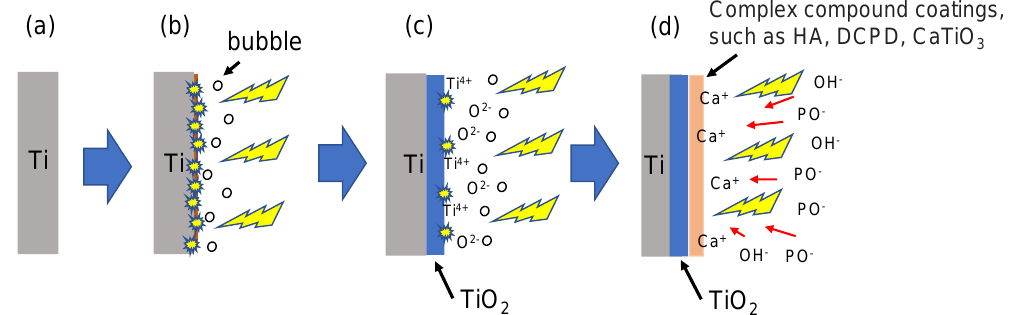
Figure 7. Schematic illustration of coating development during micro-arc oxidation discharge process on titanium substrate ( a ) Stage 1, ( b ) Stage 2, ( c ) Stage 3 and ( d ) Stage 4.